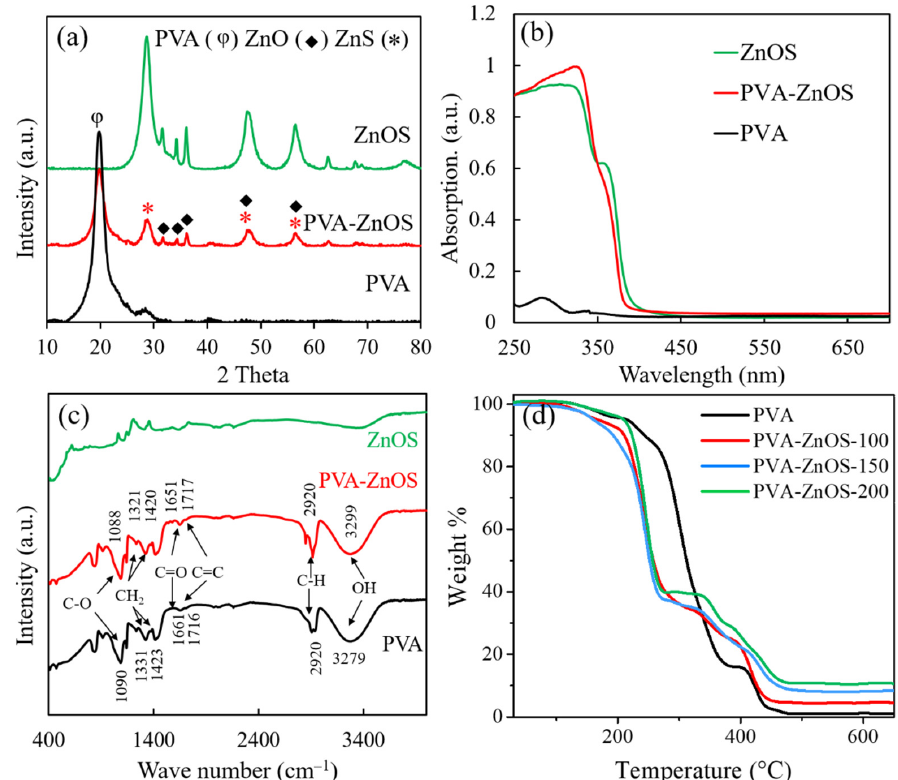
Figure 3. ( a ) XRD pattern of pure PVA, ZnOS, and PVA ‐ ZnOS100; ( b ) UV ‐ vis absorption spectra of PVA, ZnOS, and PVA ‐ ZnOS100; ( c ) FTIR spectra of PVA, ZnOS, and PVA ‐ ZnOS100; and ( d ) TGA analysis of PVA and PVA with different ZnO ‐ ZnS contents .